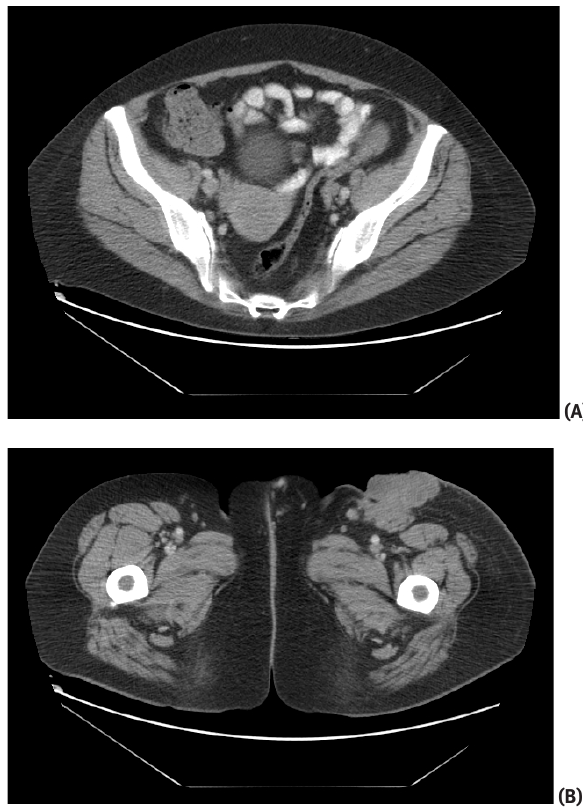
Figure 5: Regression of the disease after targeted therapy in February 2015. Compared to baseline (Figure 2) a partial response was